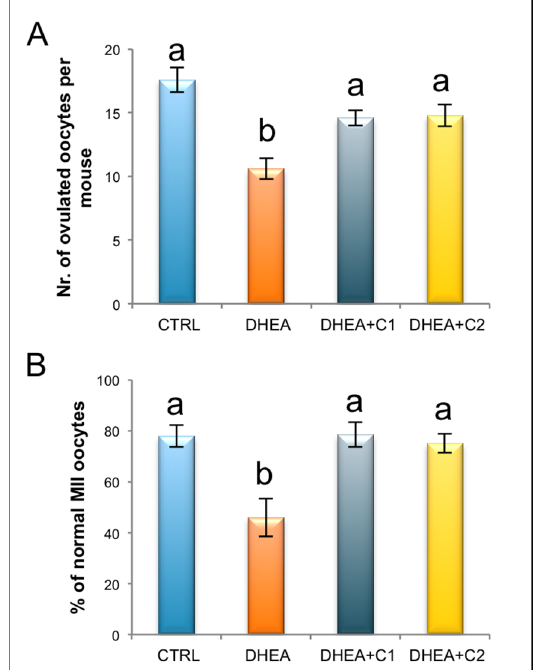
Figure 3. Administration of carnitine formulations improved number and quality of ovulated MII oocytes. Five mice per group were subjected to ovarian stimulation to induce superovulation. ( A ) Mean number of ovulated oocytes per mouse in CTRL, DHEA, DHEA + C1, and DHEA + C2 mice are shown. ( B ) Percentage of normal metaphase II (MII) oocytes in CTRL, DHEA, DHEA + C1, and DHEA + C2 mice are shown. Values are presented as means ± SEM. a, b p < 0.05, t -test.